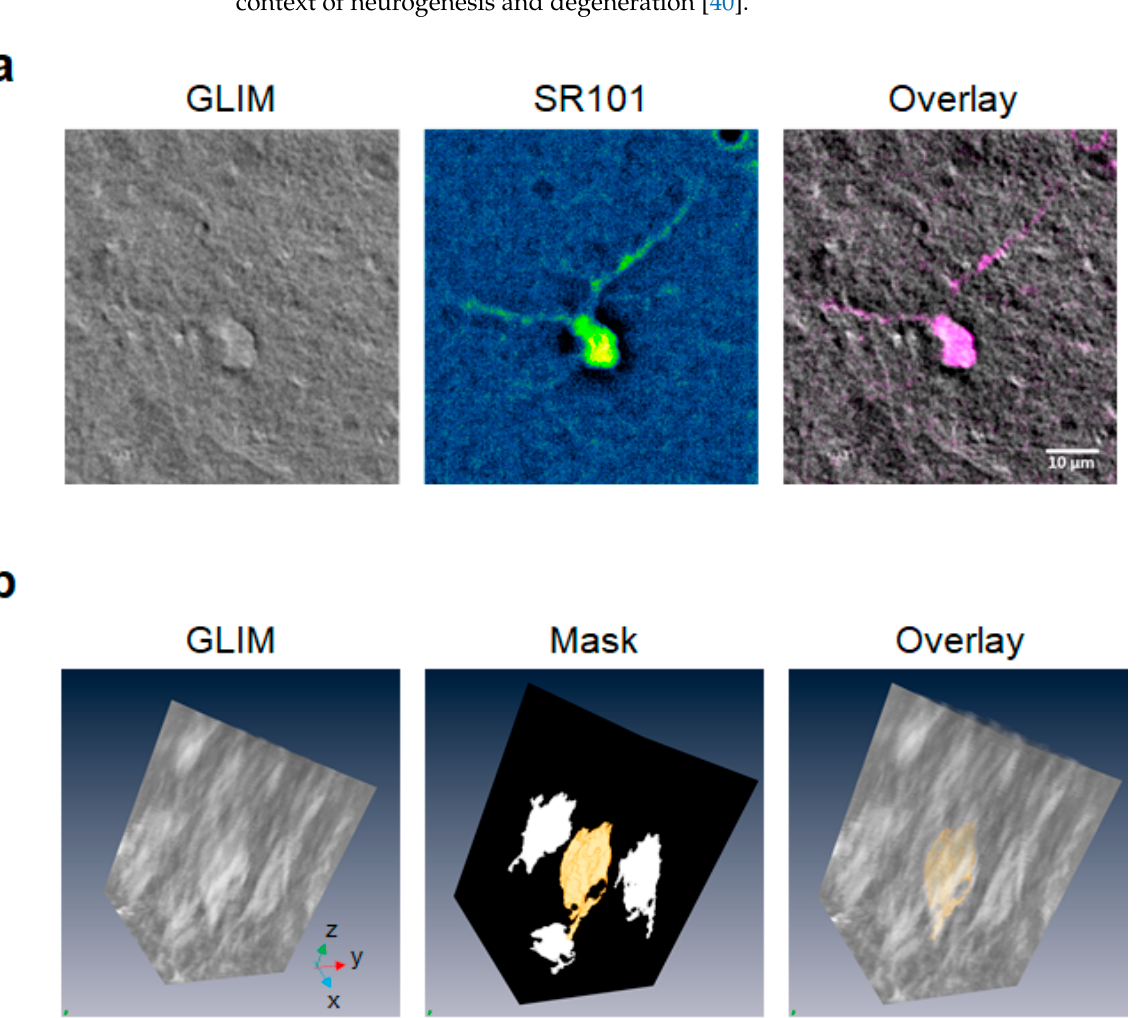
Figure 4. Astrocytes during the circadian cycle are indistinguishable by electrophysiology. ( a ) Comparison of day vs. night cells shows no statistically significant difference in membrane potential and resistance values. ( b ) GLIM reports different phase maps for normal and damaged cells (63×/1.0NA objective).